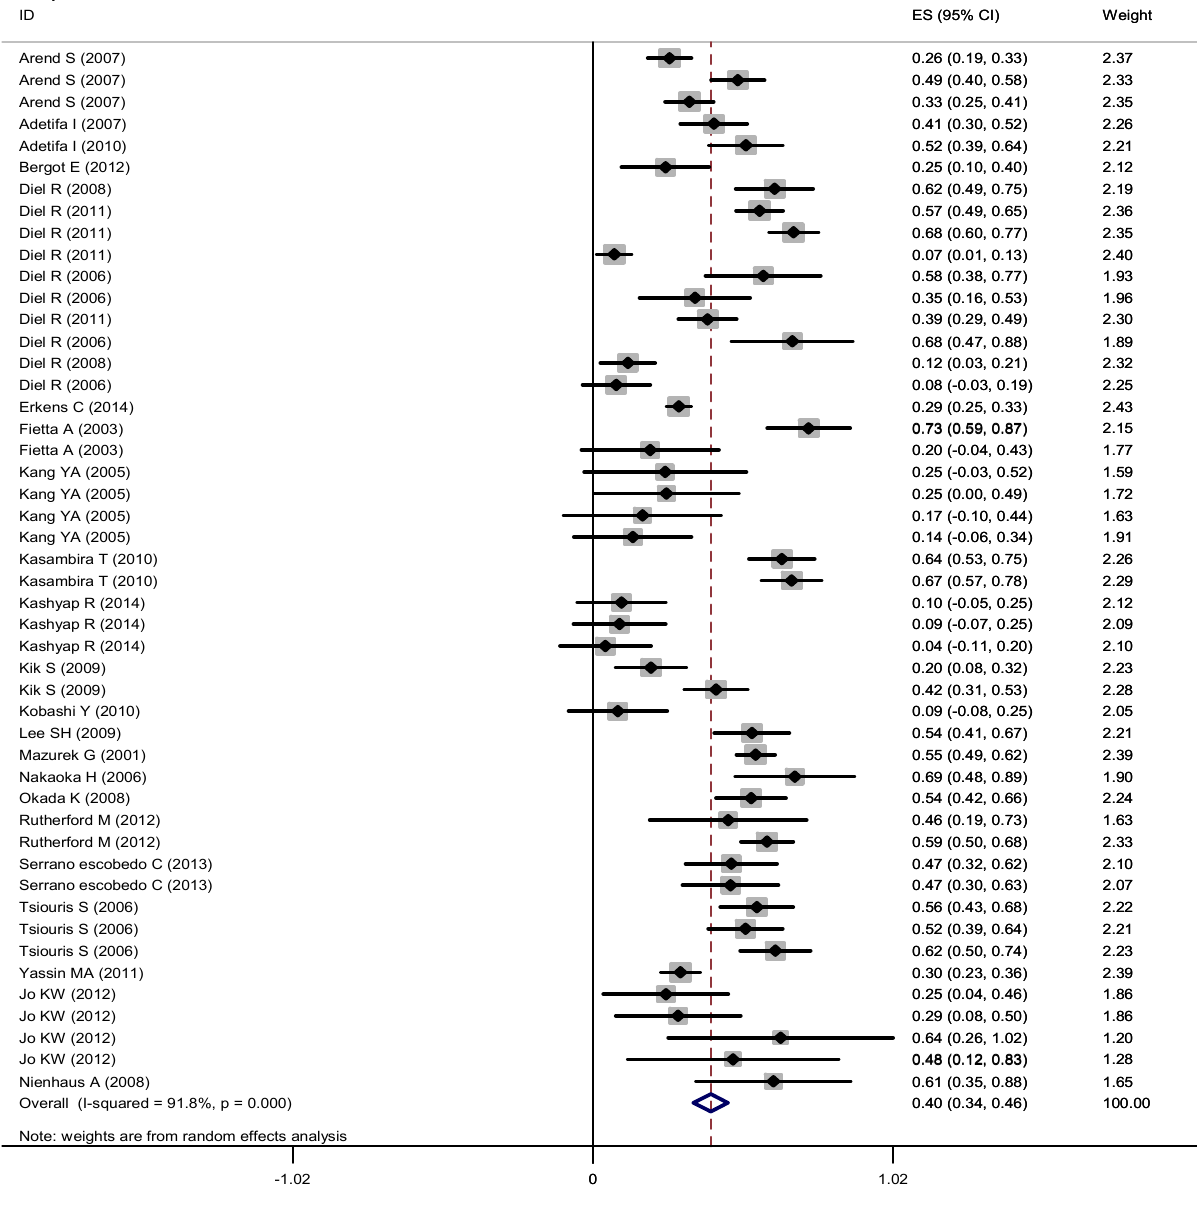
Figure 2. The pooled kappa coefficient for agreement between TST and QFT-GIT among people with high-risk contacts. TST, tuberculin skin test; QFT-GIT, QuantiFERON-TB Gold in-tube test; ES, effect size.